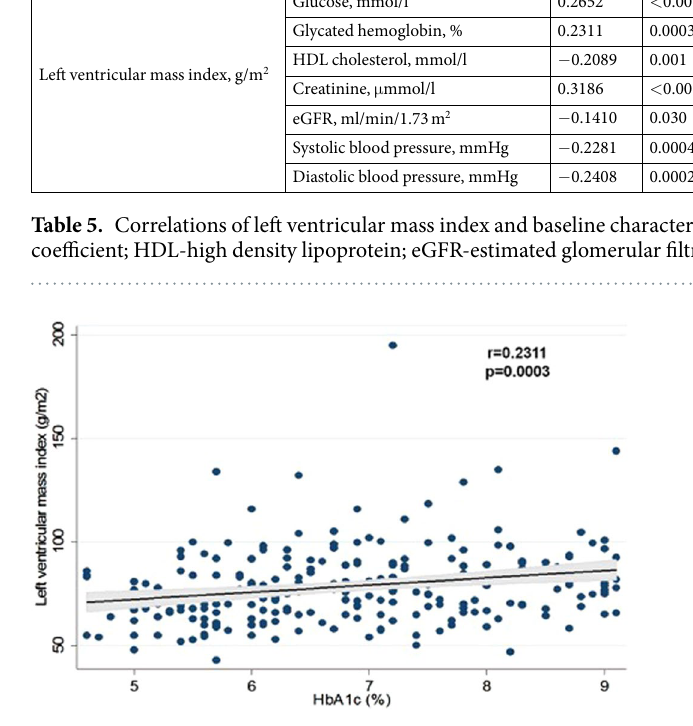
Figure 1. Correlation of left ventricular mass index and glucose.